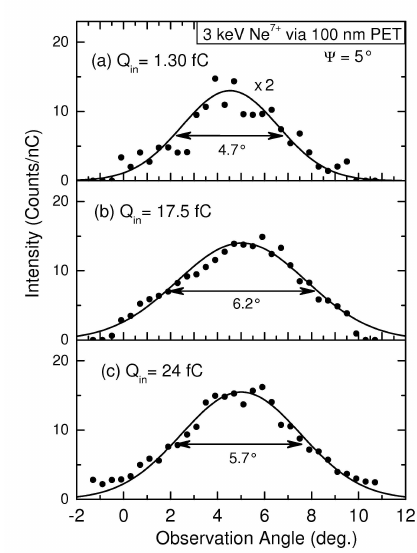
Figure 4. Transmission profiles of 3-keV Ne 7 + ions for capillaries with a diameter of 100 nm. The tilt angle is ψ = 5 ◦ . The profiles were measured just after the insertion of the charge Q in given in each graph. The profiles are fitted by Gaussians drawn as solid lines. Data taken from Ref.